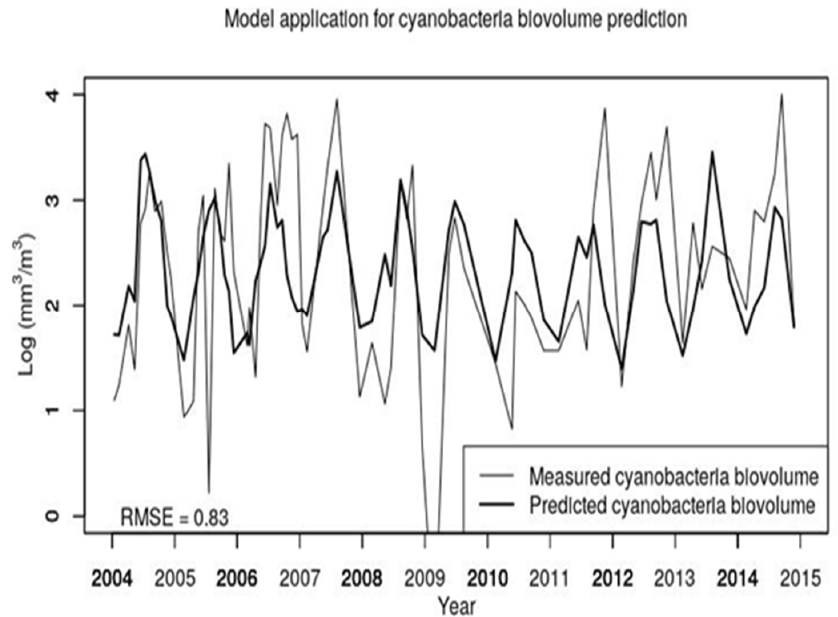
Figure 5. Measured and predicted cyanobacteria biovolumes at Lake Varese for all samples collected during the period 2004–2014. Predicted values are calculated using model No.2 of Table 3. RMSE indicates the root mean square error of predicted vs. measured values.